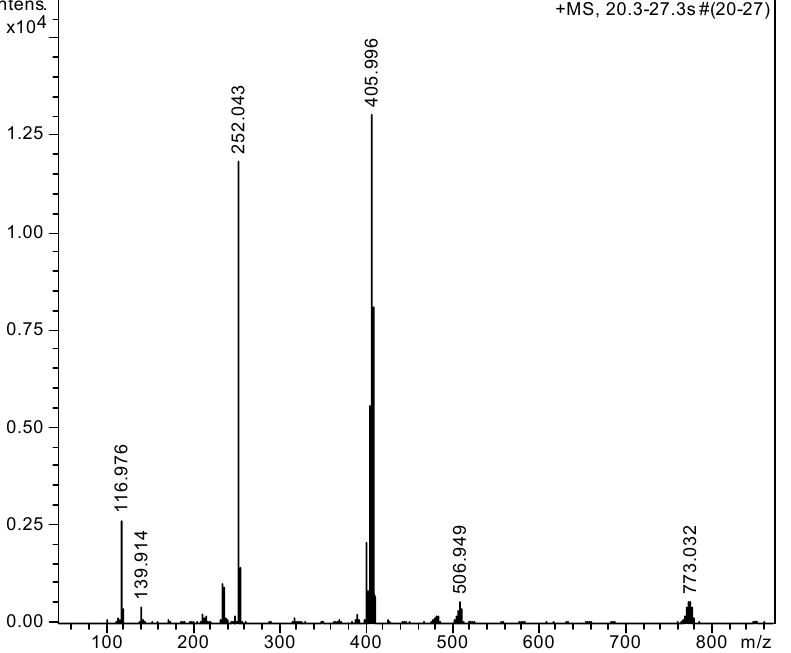
Figure 9. Measured ( a ) and calculated ( b ) isotope pattern of [( η 6 - p -cym)Ru(Ida)]+K + ion.